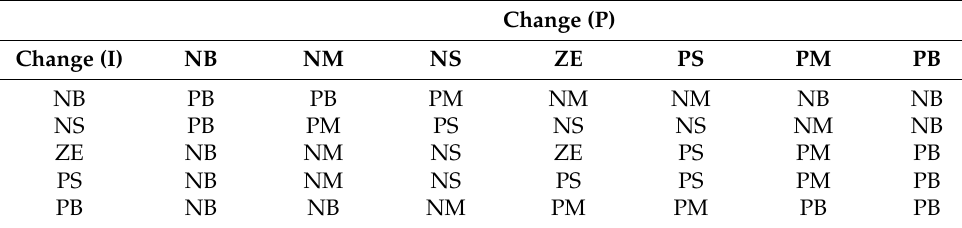
Table 3. MPPT rules for an Interval Fuzzy Type 2